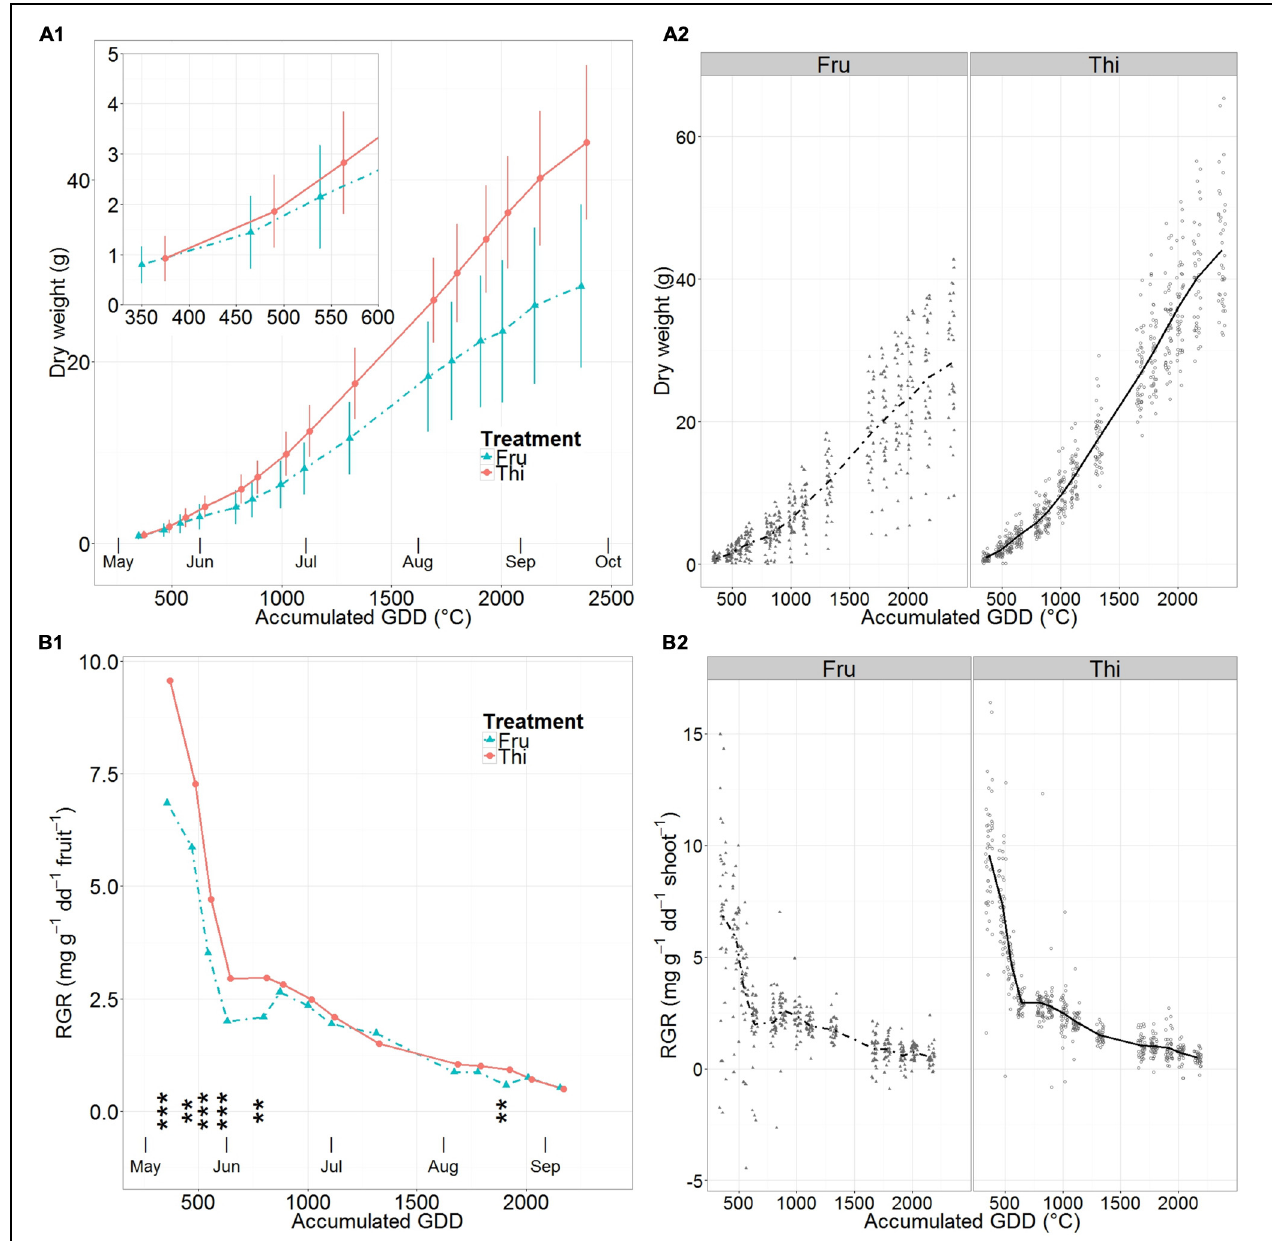
FIGURE 5 | Mean apple dry weight (A) and relative growth rates (RGR) (B) on fruited (FRU) and thinned (THI) trees vs. the accumulated growing degree days (GDD) after bloom. A synthetic summary of the mean response for the two treatments (FRU, solid; THI, dotted) is given (A1,B1) . Vertical lines indicate standard deviations. In (B1) stars indicate the level of significant differences between RGR of FRU and THI trees ( ∗∗ < = 0.01, ∗∗∗ < = 0.001). Fruits that presented pest damage were removed from the dataset. A comparison between FRU and THI, with individual observations in the background, is shown (A2,B2)